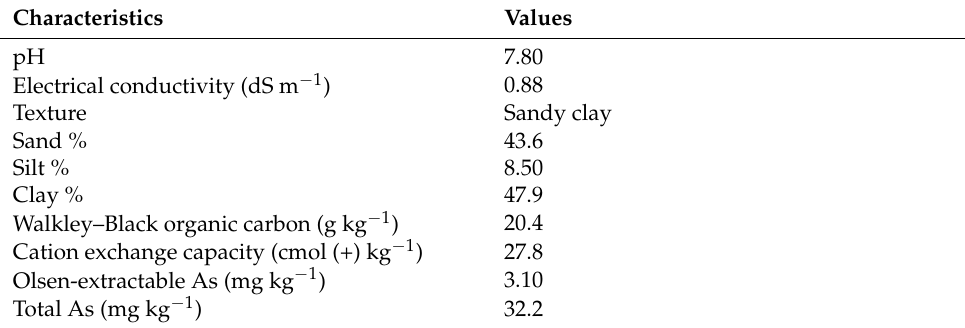
Table 3. Characterization of arsenic-contaminated soil collected from farmer fields in Mitrapur, West Bengal,